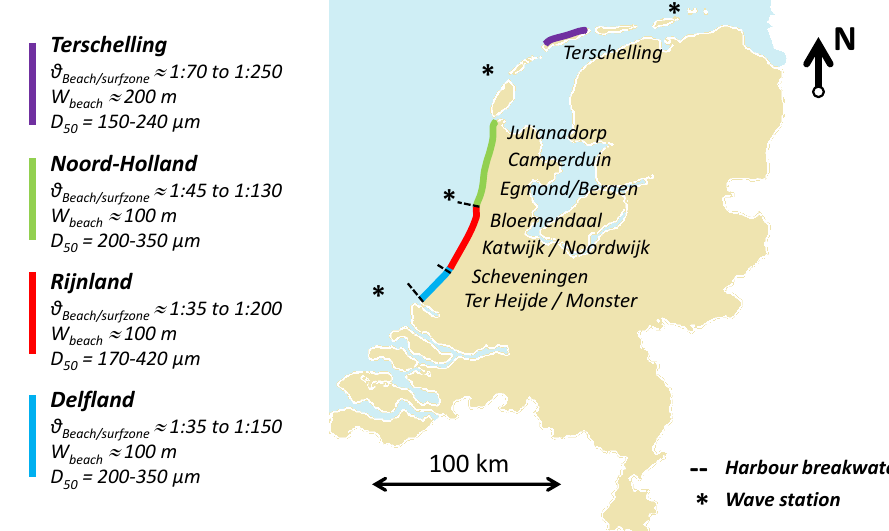
Figure 1. Overview of locations of considered nourishments along the Dutch coast and typical